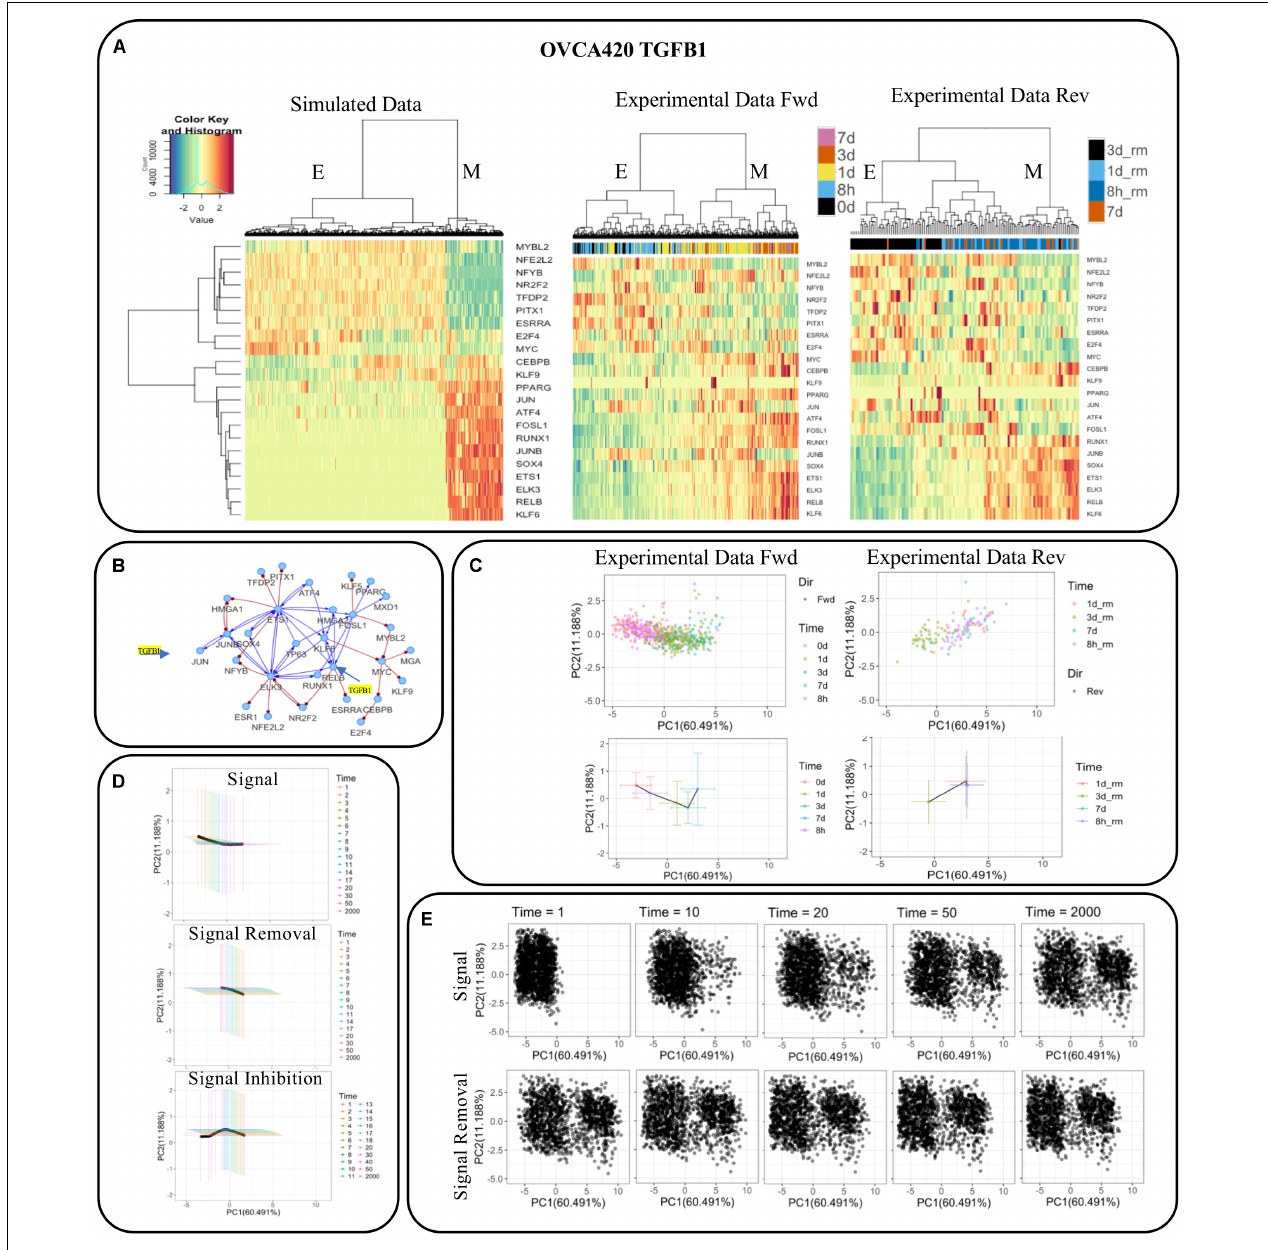
FIGURE 7 | Comparison of network simulations on 2000 RACIPE models with experimental observations for OVCA420 treated with TGFB1 signaling. (A) Hierarchical clustering of simulated and experimental activities. (B) The network topology, in which TGFB1 signaling is applied to JUN and RELB. (C) Experimental activities (top) and their mean and standard deviation (bottom) during signal induction (left) and removal (right) projected on first two principal components of the simulated data. (D) Mean and standard deviation of the simulated profiles of the E-state models during signal induction (top), removal (middle), and inhibition (bottom) at multiple time points projected on the first two principal components as in (C) . (E) Simulated profiles of the E-state models during signal removal and induction at multiple time points projected on the first two principal components as in (C) .